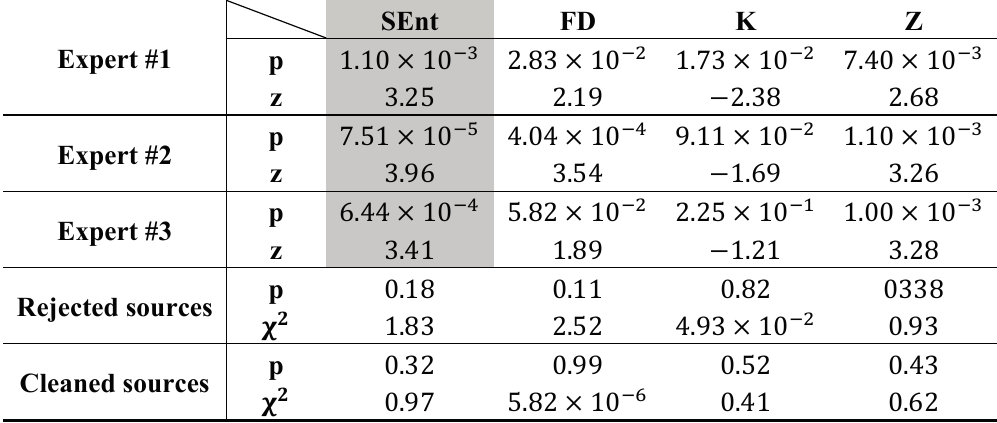
Table 4. Statistical comparison of the features for artifacts sources versus clean sources (two-sided Wilcoxon ranksum test) for each expert considered independently, and group effects comparing rejected sources between experts and the clean sources between experts (Kruskal-Wallis test). All subjects were aggregated for this test. Rows indicate p-values and the Wilcoxon z-score or Kruskal-Wallis Chi² statistics. Gray background indicates the most powerful feature (sample